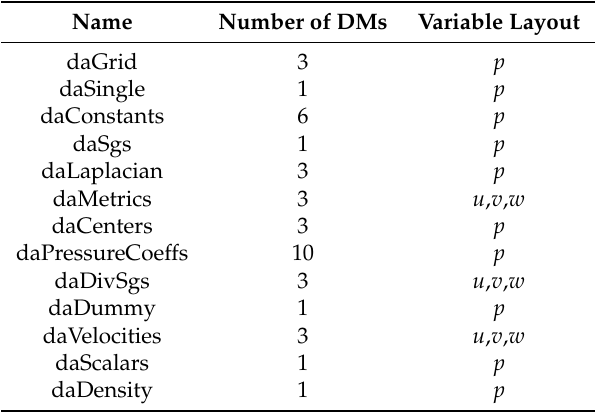
Table 2. GCCOM Data Managment Objects (DMs) and variable layout